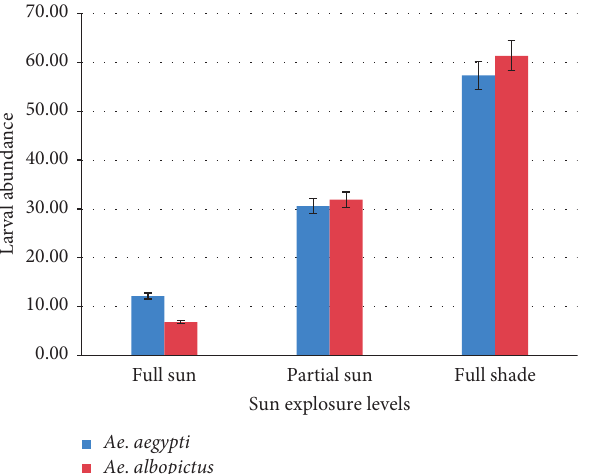
Figure 8: Relative abundance of larvae in containers with different shady levels.